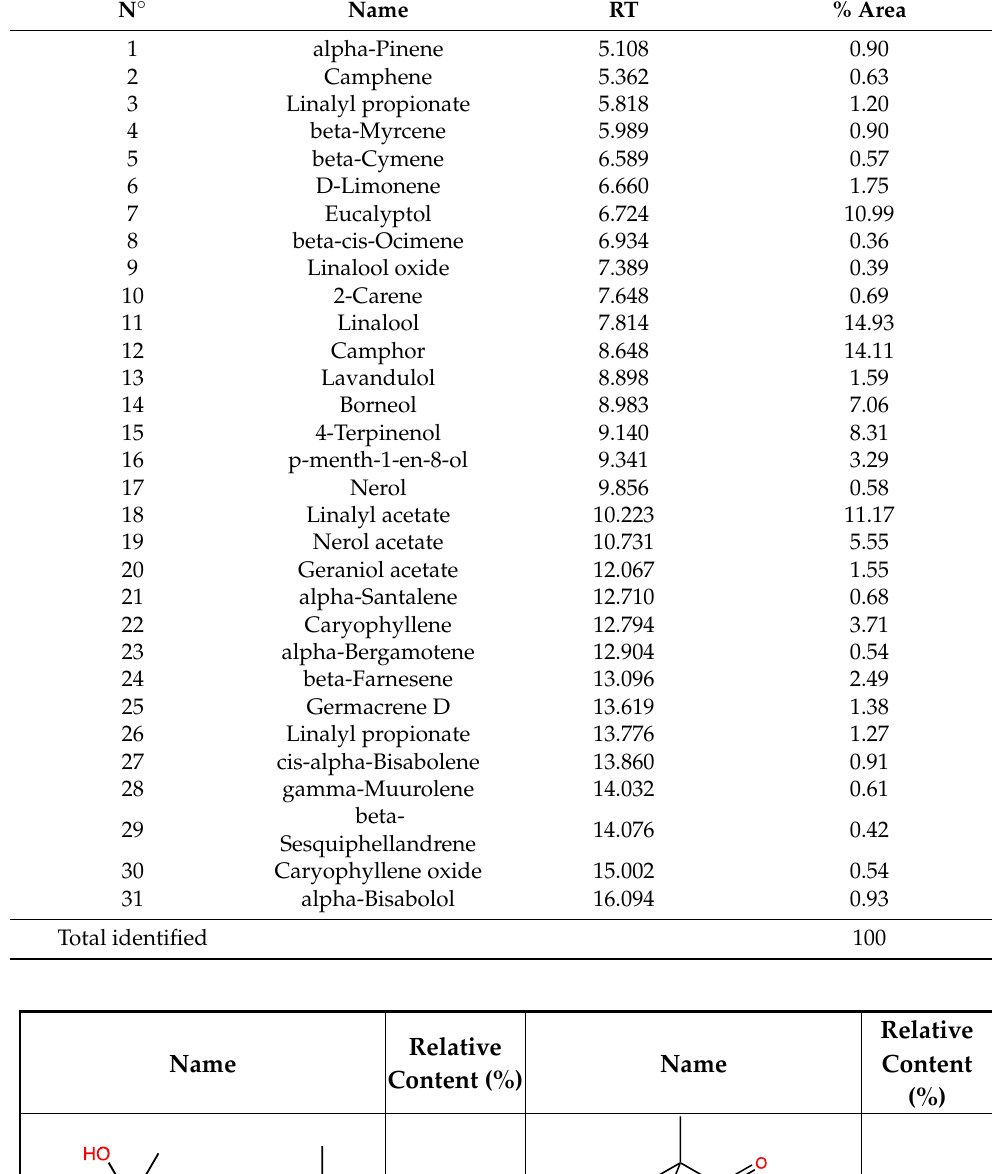
Table 1. The main compounds of the essential oil of L. officinalis. RT: Retention Time.